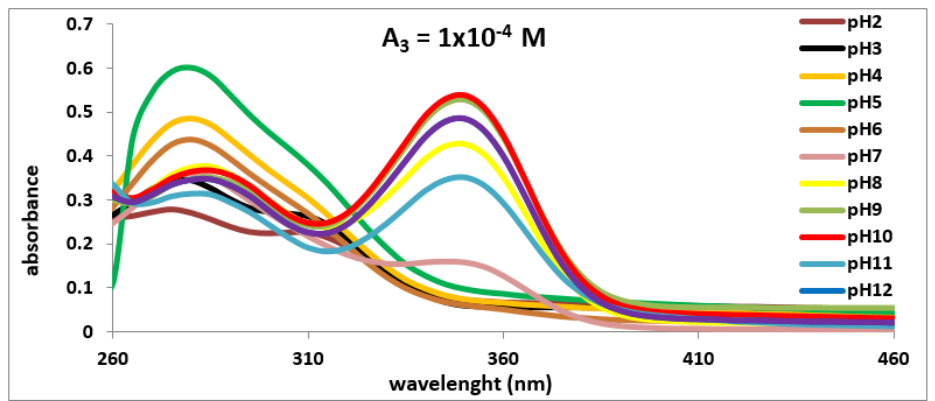
Fig. 9. Electron absorption spectra of Schiff base (A 3 ) in different pH solutions